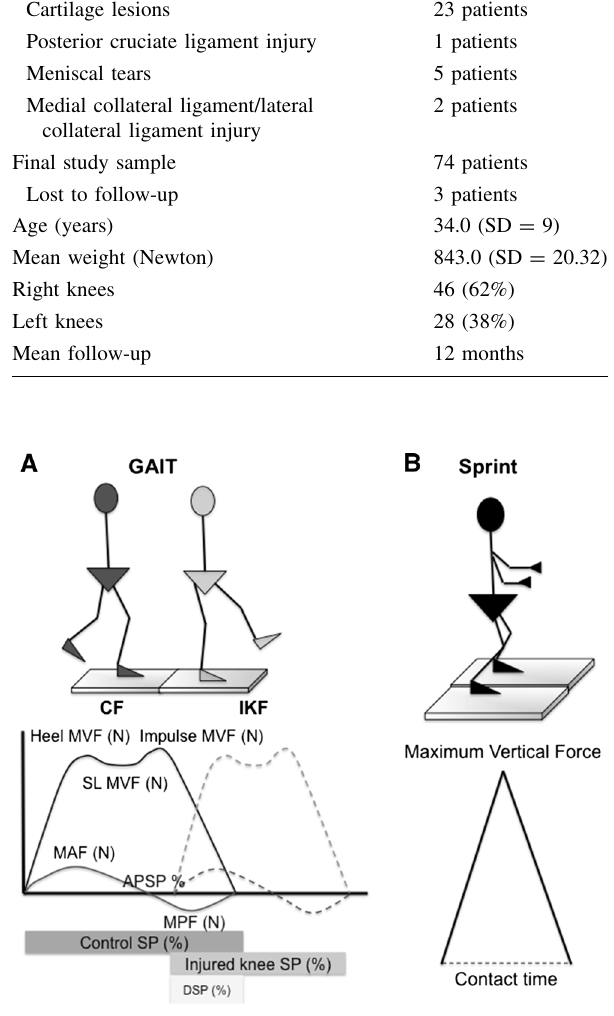
Fig. 1 a Gait test and kinetics graph. Subjects walked along a 5-m wooden walkway in which one of the force plates was embedded. Subjects were told to walk at a self-selected comfortable pace. b Sprint test and kinetics graph. The sprint test was performed with the patient standing on both platforms. After an initial trial, they were instructed to sprint as fast as possible for 5 s ( CF control foot, IKF injured-knee foot, Max maximum, AP